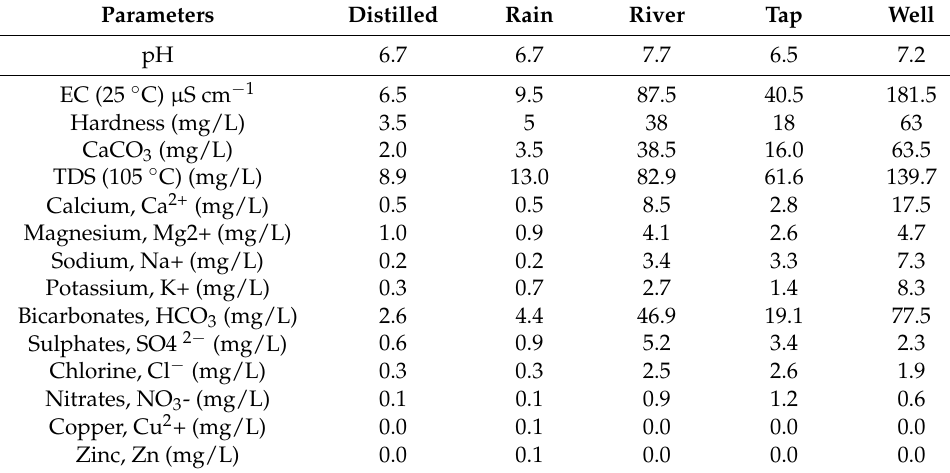
Table 4. Chemical composition of various water